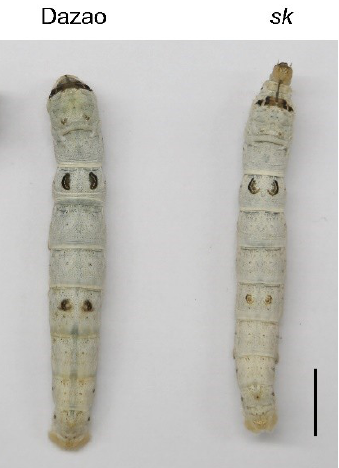
Figure 1. Phenotypes of the stick mutant ( sk / sk ) and wild-type strain (Dazao) at L5D3. The sk mutant larvae exhibited a stick-like slender, firm larval body, which was particularly observed in L5D3 larvae. Scale bar: 1 cm.